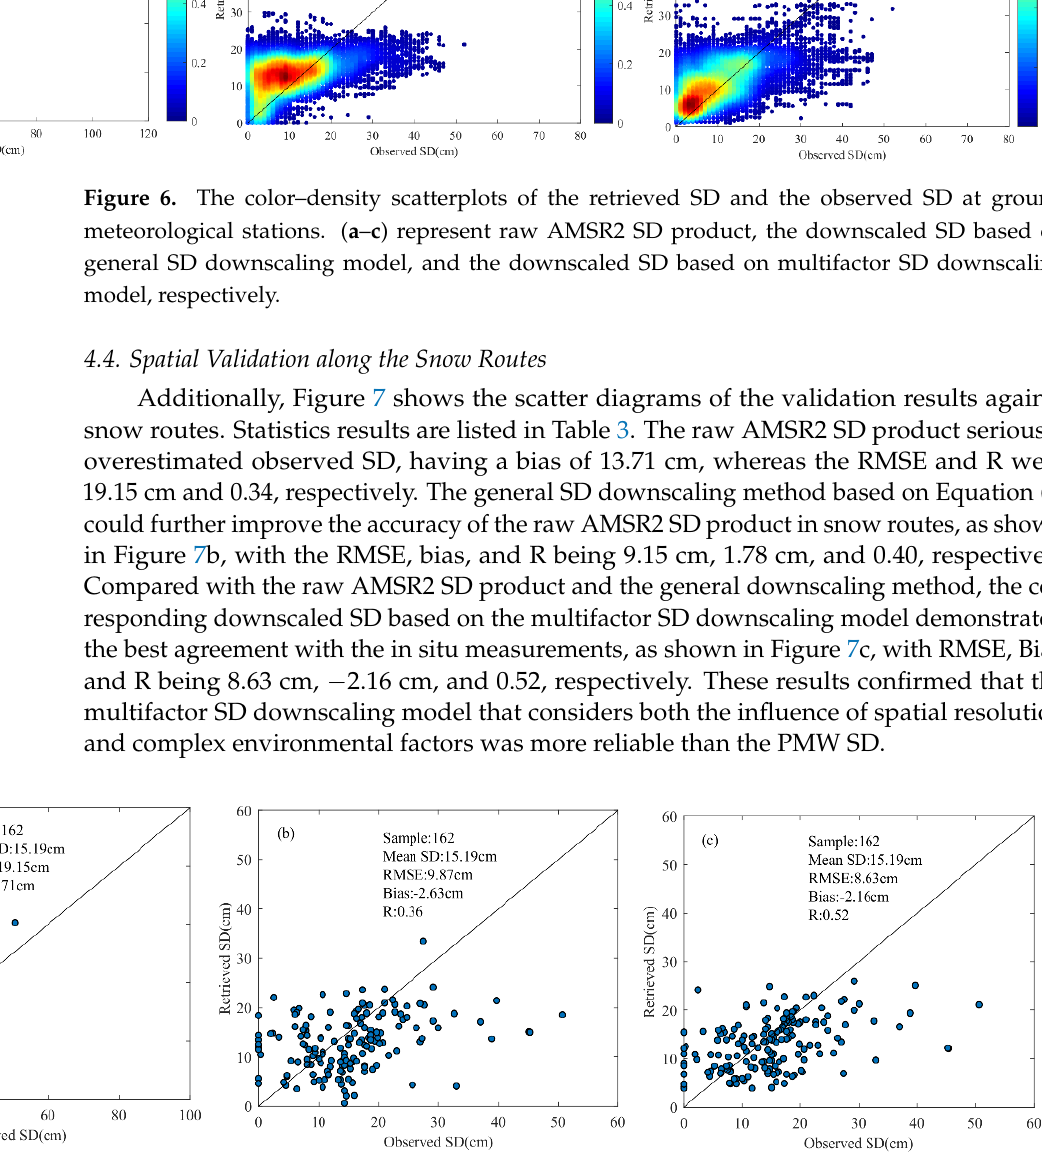
Figure 7. Scatter plots of retrieved SD and observed SD along the snow routes. ( a – c ) represent raw AMSR2 SD product, the downscaled SD based on general SD downscaling model, and the downscaled SD based on multifactor SD downscaling model, respectively.